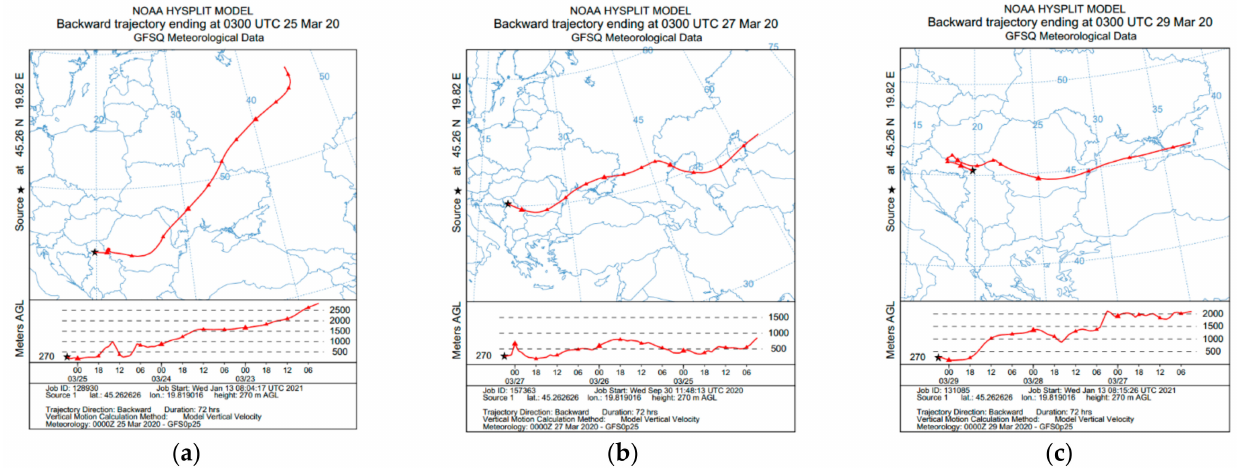
Figure A2. The air mass back trajectory for the city of Novi Sad on ( a ) 25 of March ( b ) 27 of March ( c ) on 29 of March.